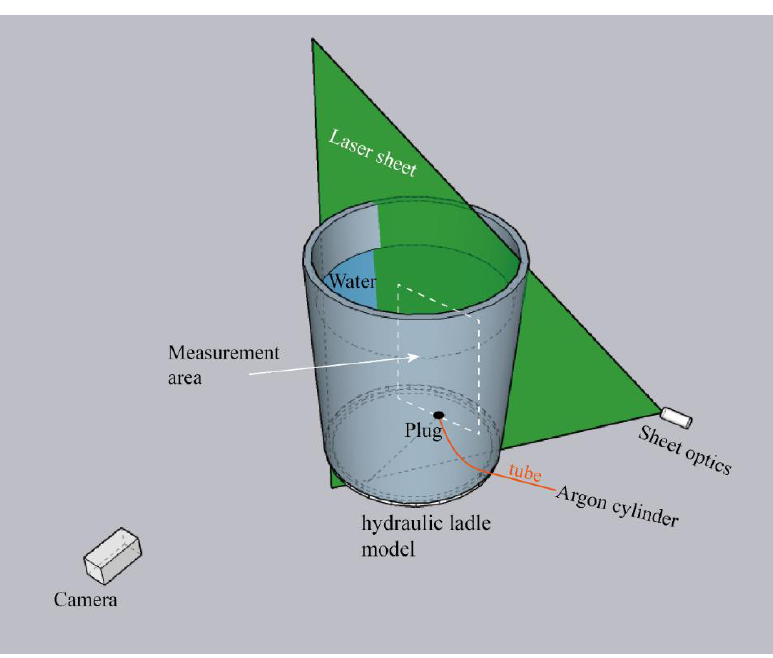
Figure 1. The schematic of the velocity measurement setup.